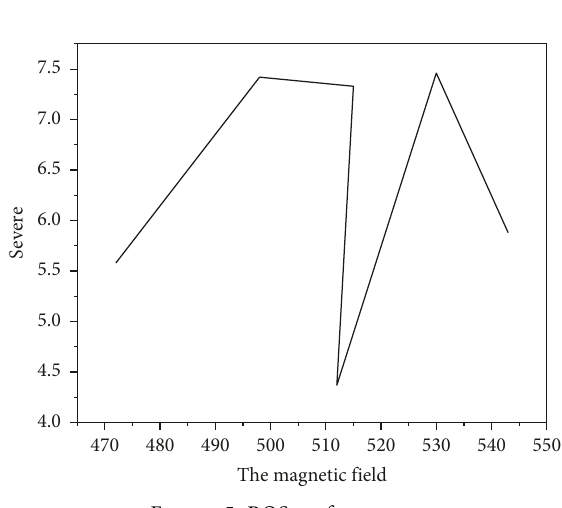
Figure 4: DOX release rate.